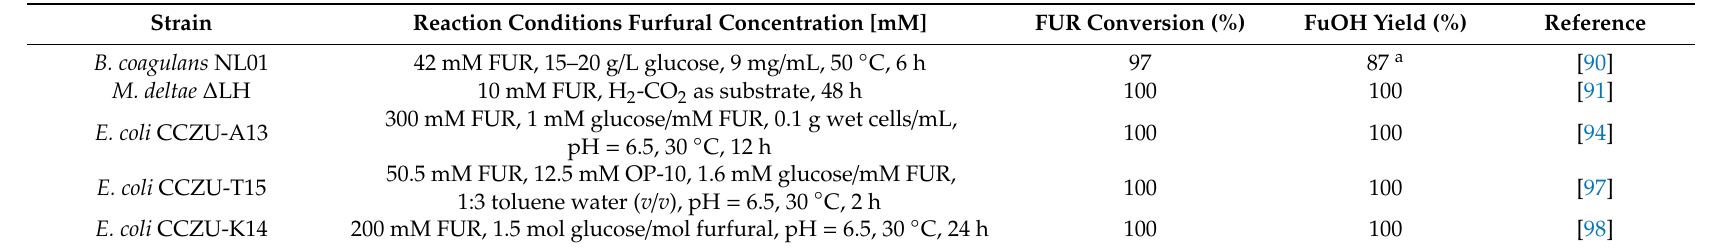
Table 1. Selected bio-catalytic systems for formation of FuOH from